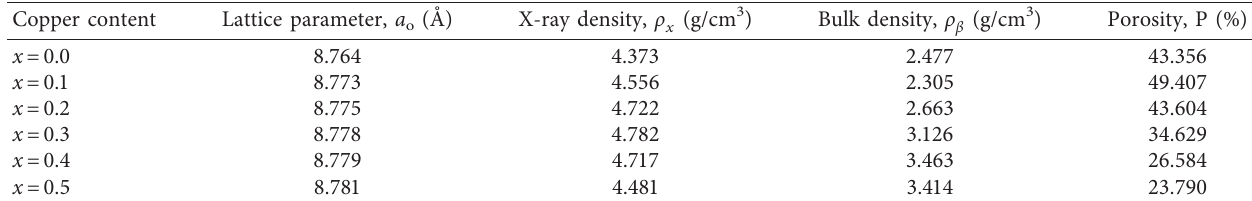
Table 1: Lattice parameter, X-ray density, bulk density, and porosity for different compositions of the sample Mg 1100 °